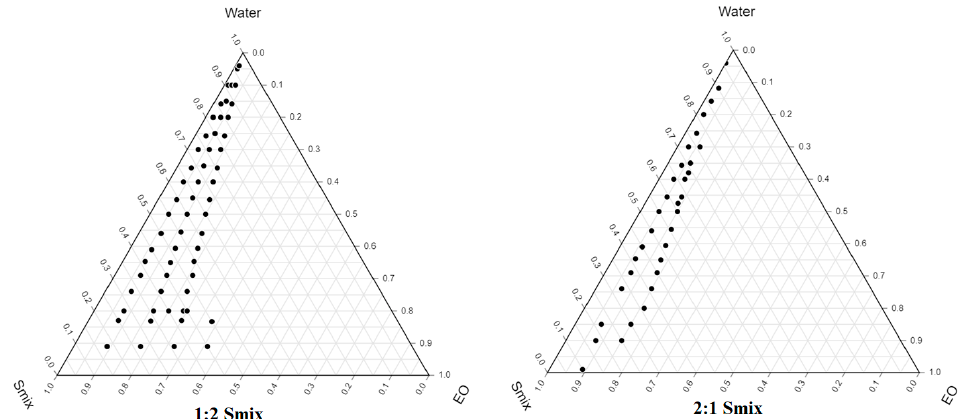
Figure 2. Pseudo ‐ ternary phase diagrams of eucalyptus oil (EO), Tween 80: THP (Smix) and water. Figure 2. Pseudo-ternary phase diagrams of eucalyptus oil (EO), Tween 80: THP (Smix) and water.